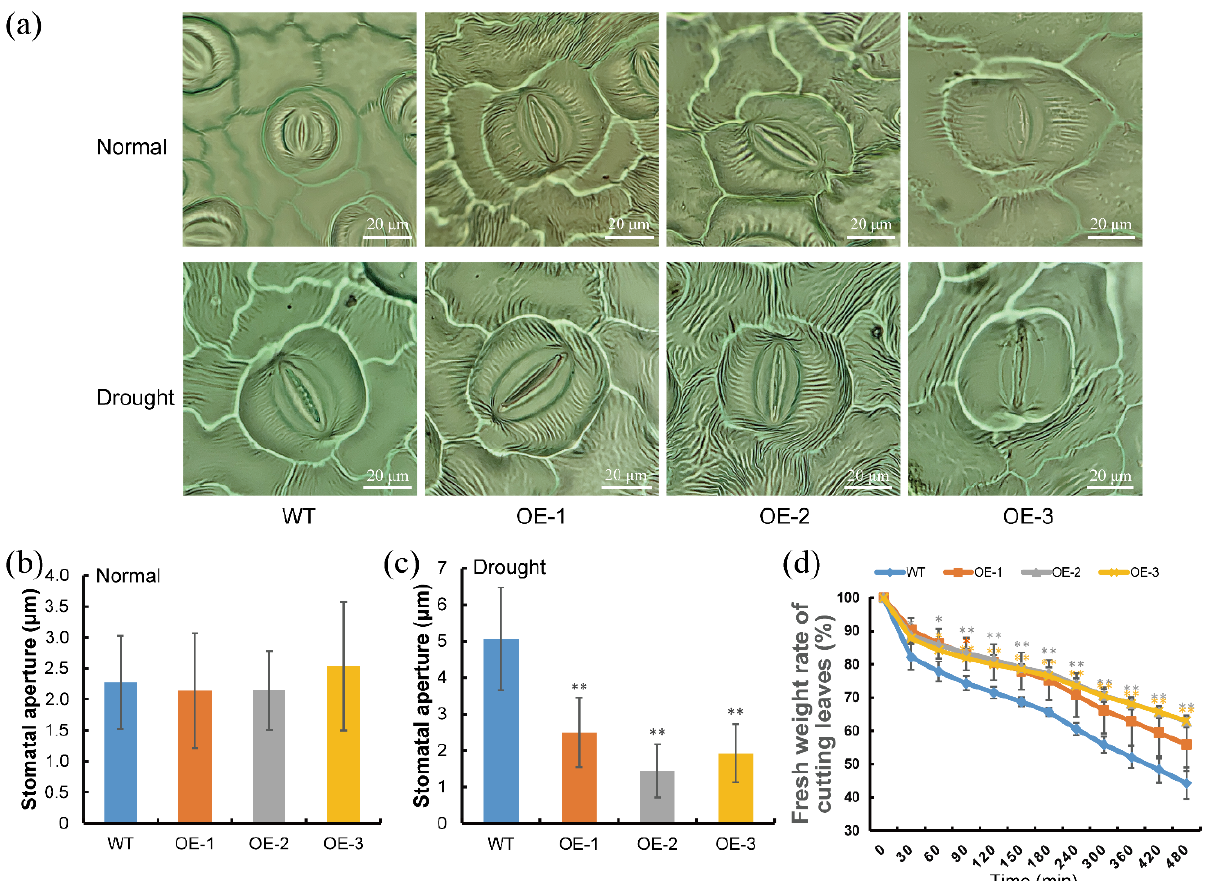
Figure 7. Stomatal aperture and water loss in transgenic lines and WT plants. ( a ) Observation of stomata in different plant leaves under normal and drought stress. ( b , c ) Stomatal apertures were measured using ImageJ software. ( b ) Normal condition and ( c ) Drought condition. Data are presented as the means ± SE ( n > 40). ( d ) The fresh weight rate of cutting leaves in OE-1, -2, -3, and WT under dehydration treatment. Error bars represent sd ( n = 3). p -values of significant difference of transgenic lines compared to the WT based on Student’s t -test, respectively (Supplementary Table S1). * and ** indicate a significant difference compared to the WT at p < 0.05 and p < 0.01 based on Student’s t -test, respectively.